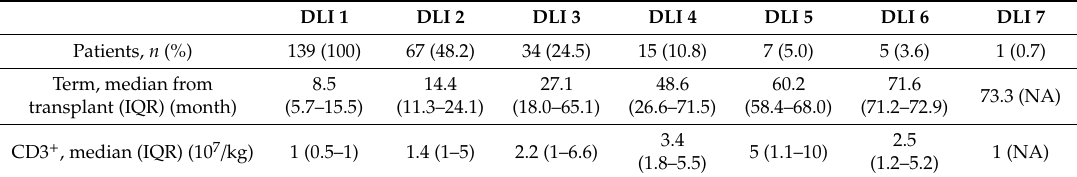
Table 2. DLI characteristics, n =